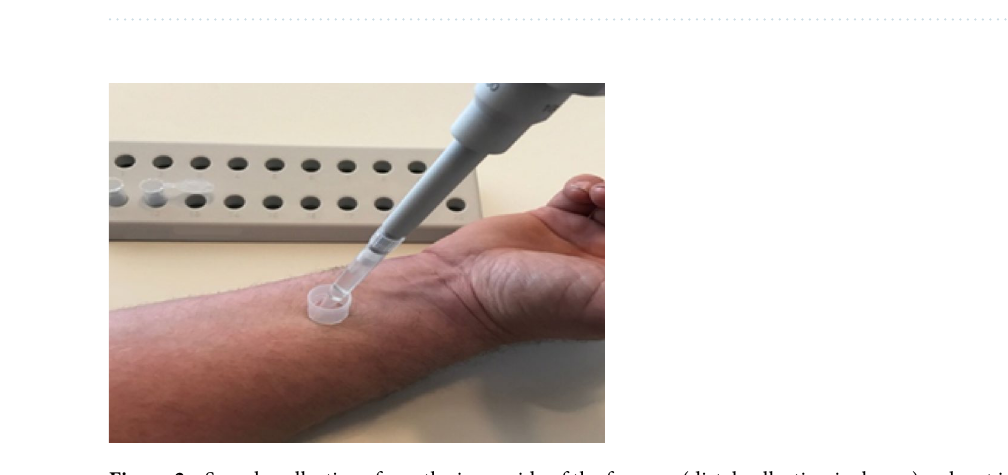
Figure 1. Sampling points (forehead, inside of the forearm distal and proximal).